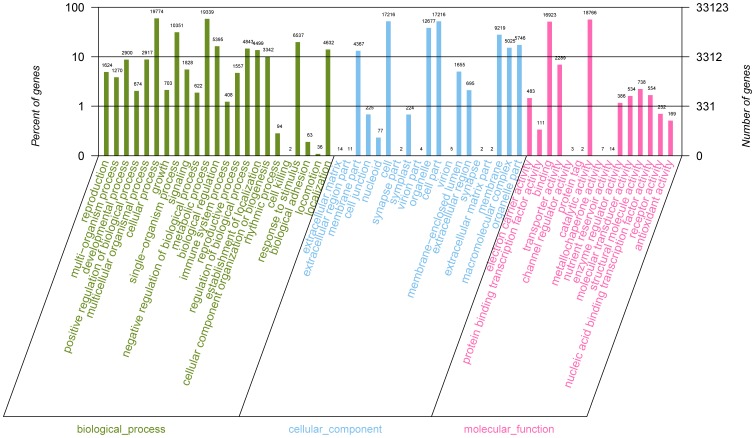
Histogram of GO classifications of assembled Chinese jujube (Ziziphus jujuba M.) unigenes.Results are summarized for three main GO categories: biological process, cellular component and molecular function.